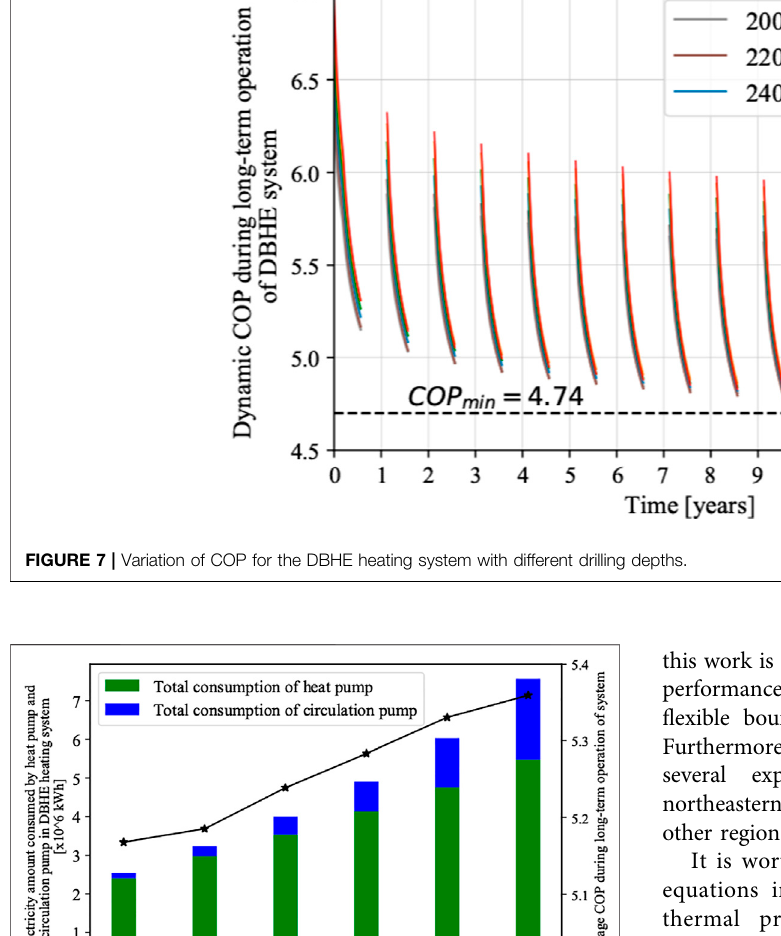
Frontiers in Earth Science |